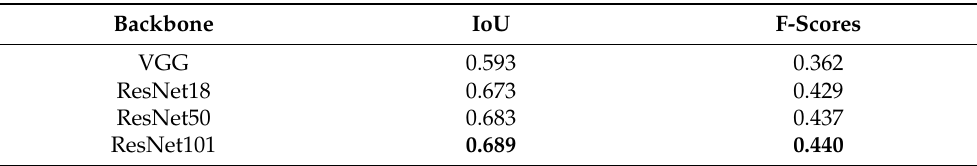
Table 3. Comparing IoU Result with different backbone network for the 2D image encoder. We highlight the best scores in bold.